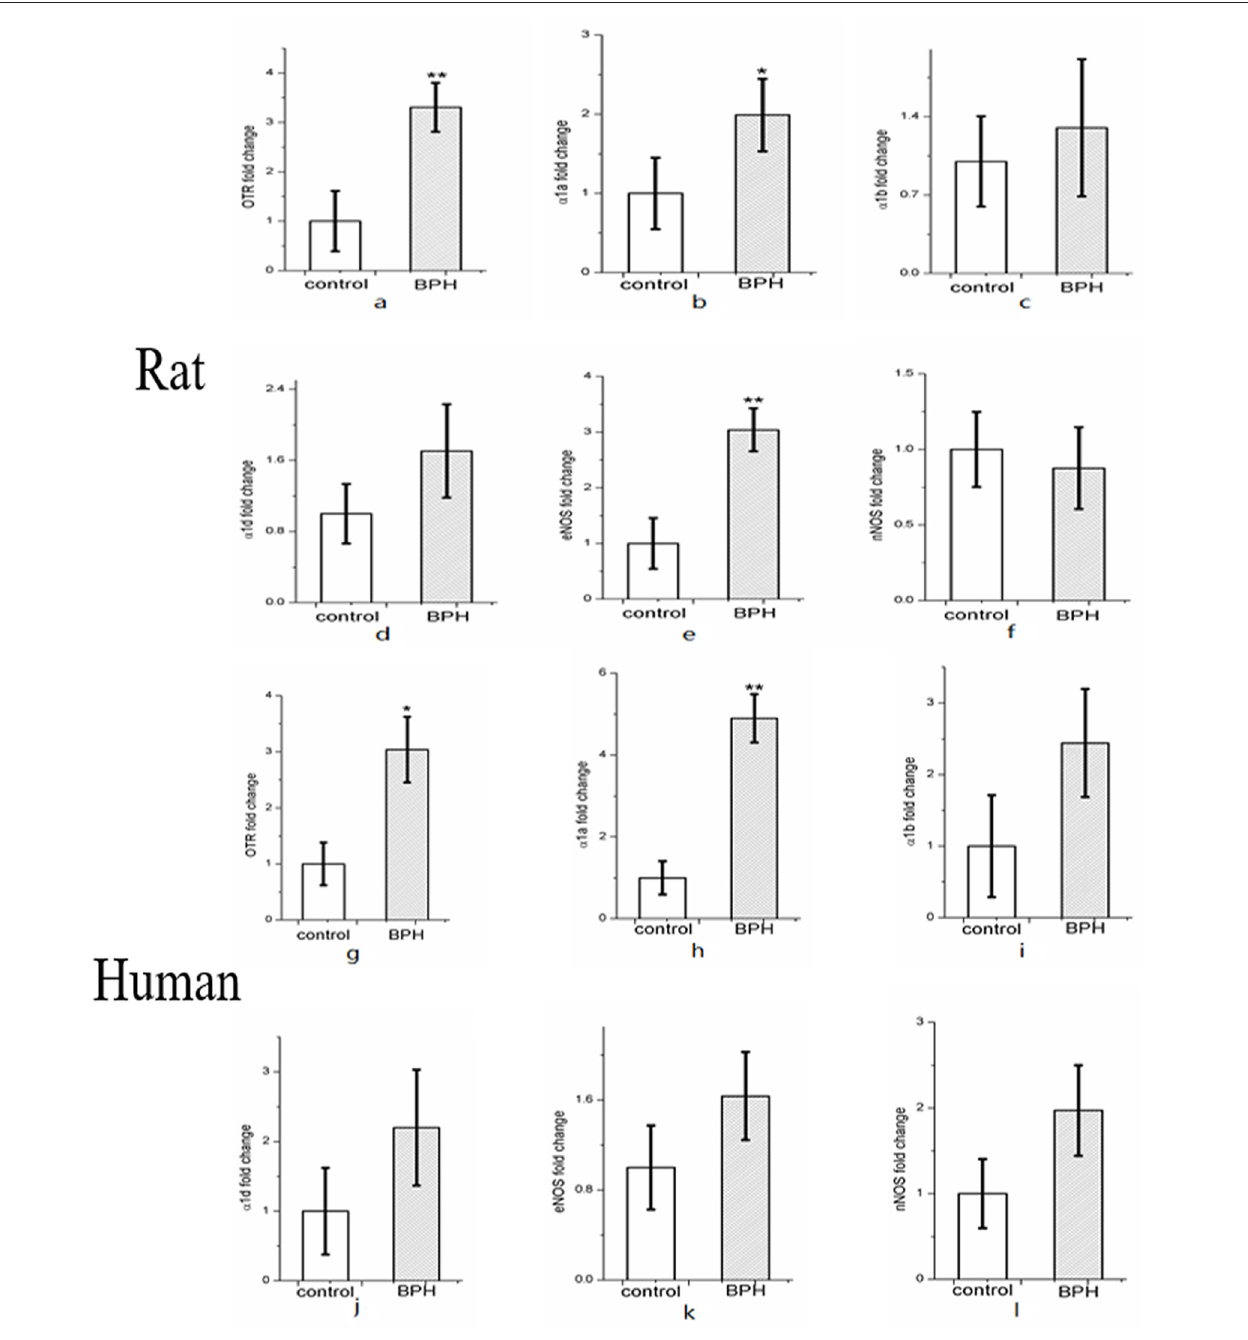
FIGURE 9 | Expression of OTR (a) , α 1-adrenoreceptor subtypes ( α 1aARs, α 1bARs, α 1dARs) (b–d) and nitric oxide synthase isoforms (eNOS and nNOS) mRNA (e–f) in rat ( n = 15, 3 replicates per experiment) and human prostate (g–l) ( n = 9, 3 replicates per experiment). Boxes, mean; bars, ± S.E.M; ** P < 0.01 vs. control; * P < 0.05 vs.